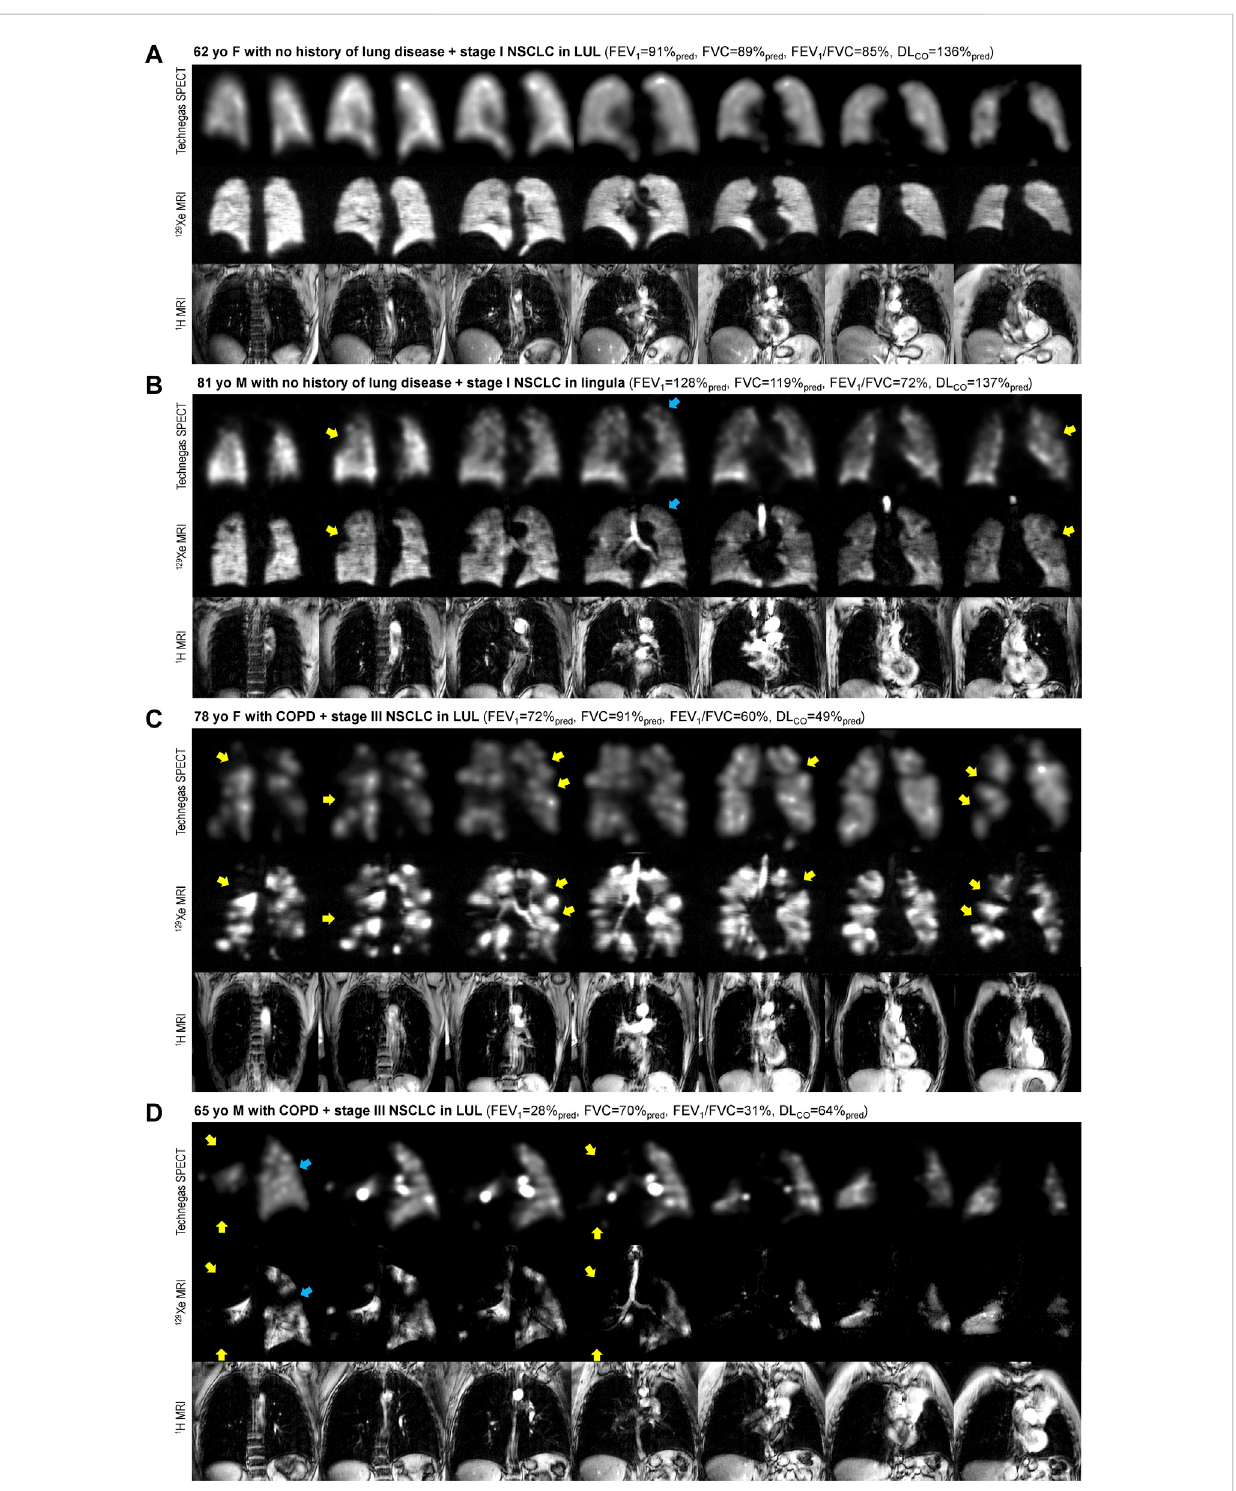
FIGURE 1 Comparison of ventilation visualized by Technegas SPECT and hyperpolarized 129 Xe MRI. Anatomically matched coronal Technegas SPECT, 129 Xe MRI, and 1 H MRI slices for four representative participants. Select examples of spatially concordant and discordant ventilation defects are highlighted by yellow and blue arrows, respectively. (A) 62-year-old female with necrotizing granuloma in left upper lobe and no history of lung disease. Technegas SPECT: VDP T =12%*,VDP K =5%; 129 XeMRI:VDP T =22%, VDP K =1%*; FEV 1 =91% pred ,FVC=89% pred ,FEV 1 /FVC =85%,DL co =136% pred . (B) 81-year- old male with stage I NSCLC in lingula and no history of lung disease. Technegas SPECT: VDP T = 28%*, VDP K = 14%; 129 Xe MRI: VDP T = 18%, VDP K = 4%*; FEV 1 = 128% pred , FVC = 119% pred , FEV 1 /FVC = 72%, DL CO = 137% pred . (C) 78-year-old female with stage III NSCLC in left upper lobe and concomitant COPD. Technegas SPECT: VDP T = 47%*, VDP K = 20%; 129 Xe MRI: VDP T = 31%, VDP K = 19%*; FEV 1 = 72% pred , FVC = 91% pred , FEV 1 /FVC = 60%, DL CO = 49% pred . (D) 65-year-old male with stage III NSCLC in left upper lobe and concomitant COPD. Technegas SPECT: VDP T = 84%*, VDP K = 52%; 129 Xe MRI: